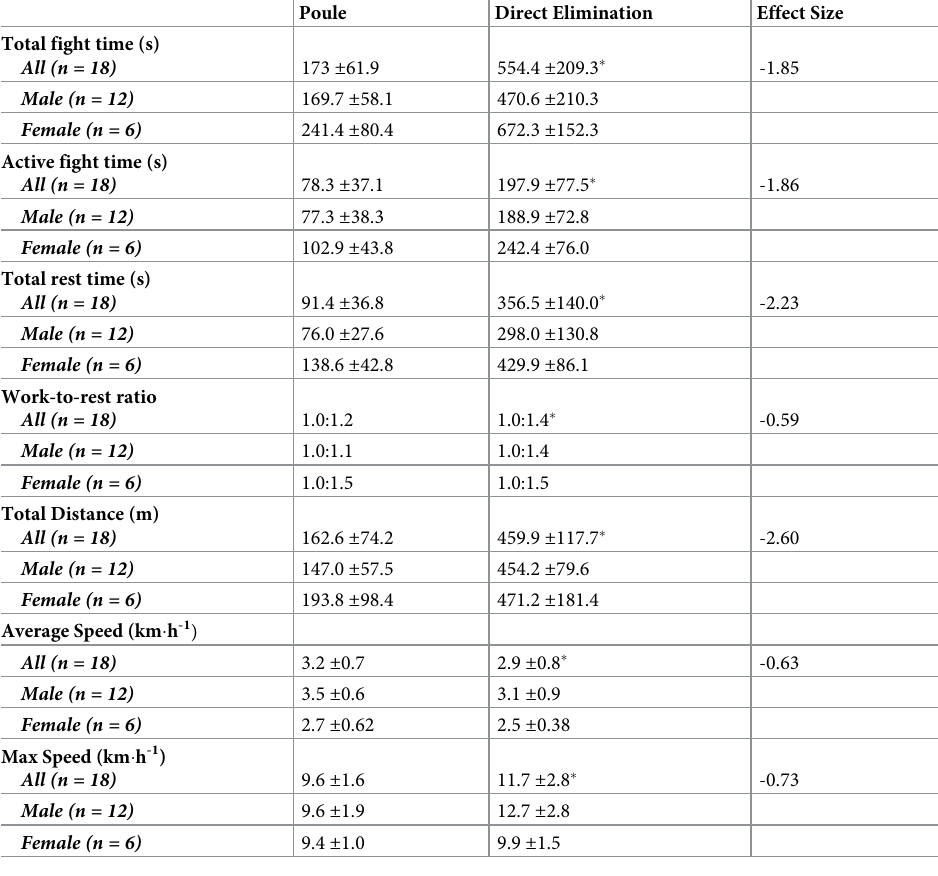
Table 4. Motion analysis variables for both poule and direct elimination